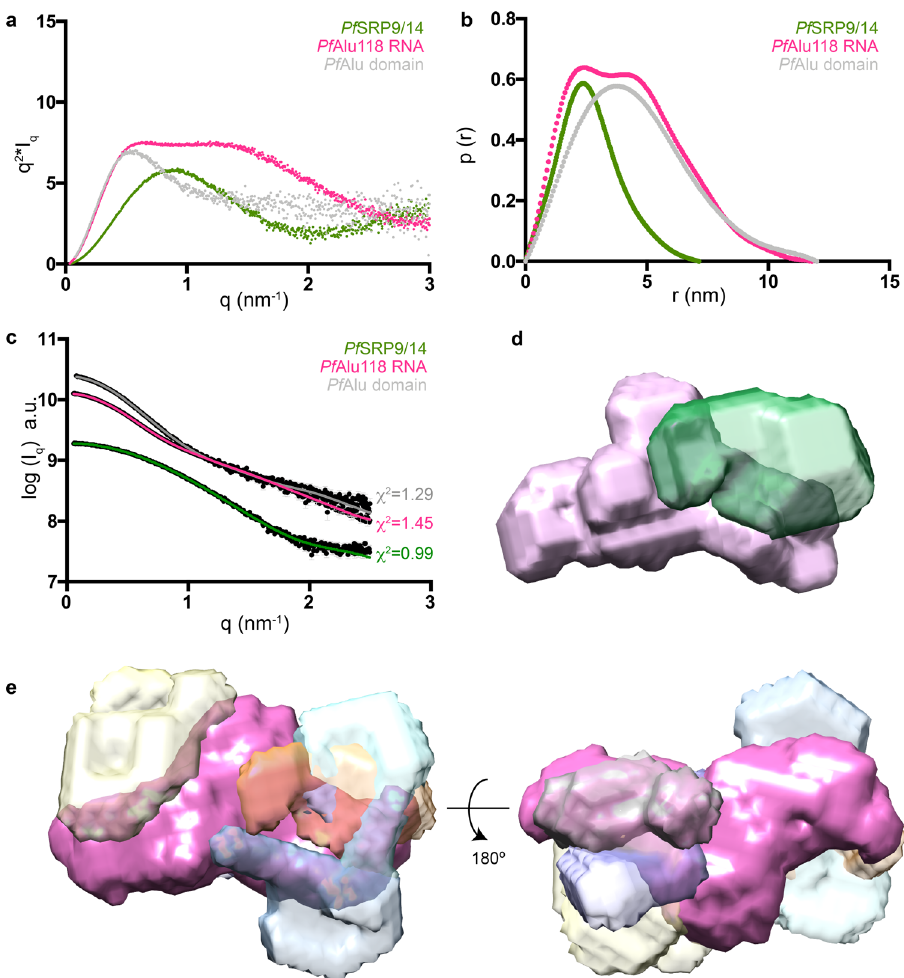
Fig. 6 SAXS analysis of the Pf Alu domain. a Kratky plots and b p(r) curves of the Pf SRP9/14 heterodimer (green), Pf Alu118 RNA (magenta), and Pf Alu domain (gray) are presented. Data for Pf SRP9/14 heterodimer and Pf Alu118 RNA have been replicated from Fig. 4a, b. c MONSA modeling of Pf Alu domain. Out of 10 MONSA runs, the data for the top-scoring run are shown. d Multi-phase ab initio models corresponding to the best-scoring MONSA run in c are shown. The RNA phase is colored in pink and protein phase in green. e Aligned, averaged, and fi ltered ab initio models of the RNA phase from 10 independent MONSA runs are shown in magenta, whereas the different positions of the protein phase occupied on the RNA are shown in various light colors. The protein phases of individual runs do not show spatial convergence but are placed overall near the three-helix junction. a.u. represents arbitrary